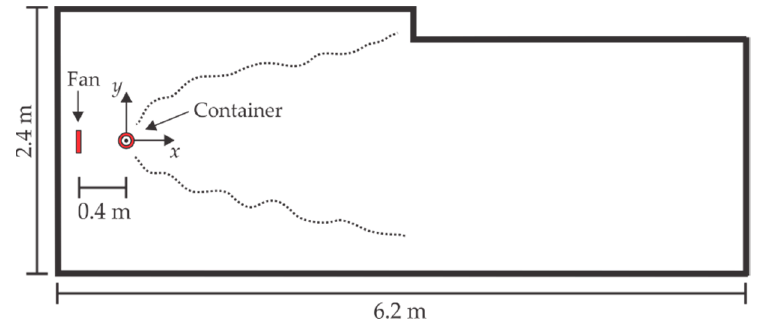
Figure 5. Room dimensions where the tests were performed.